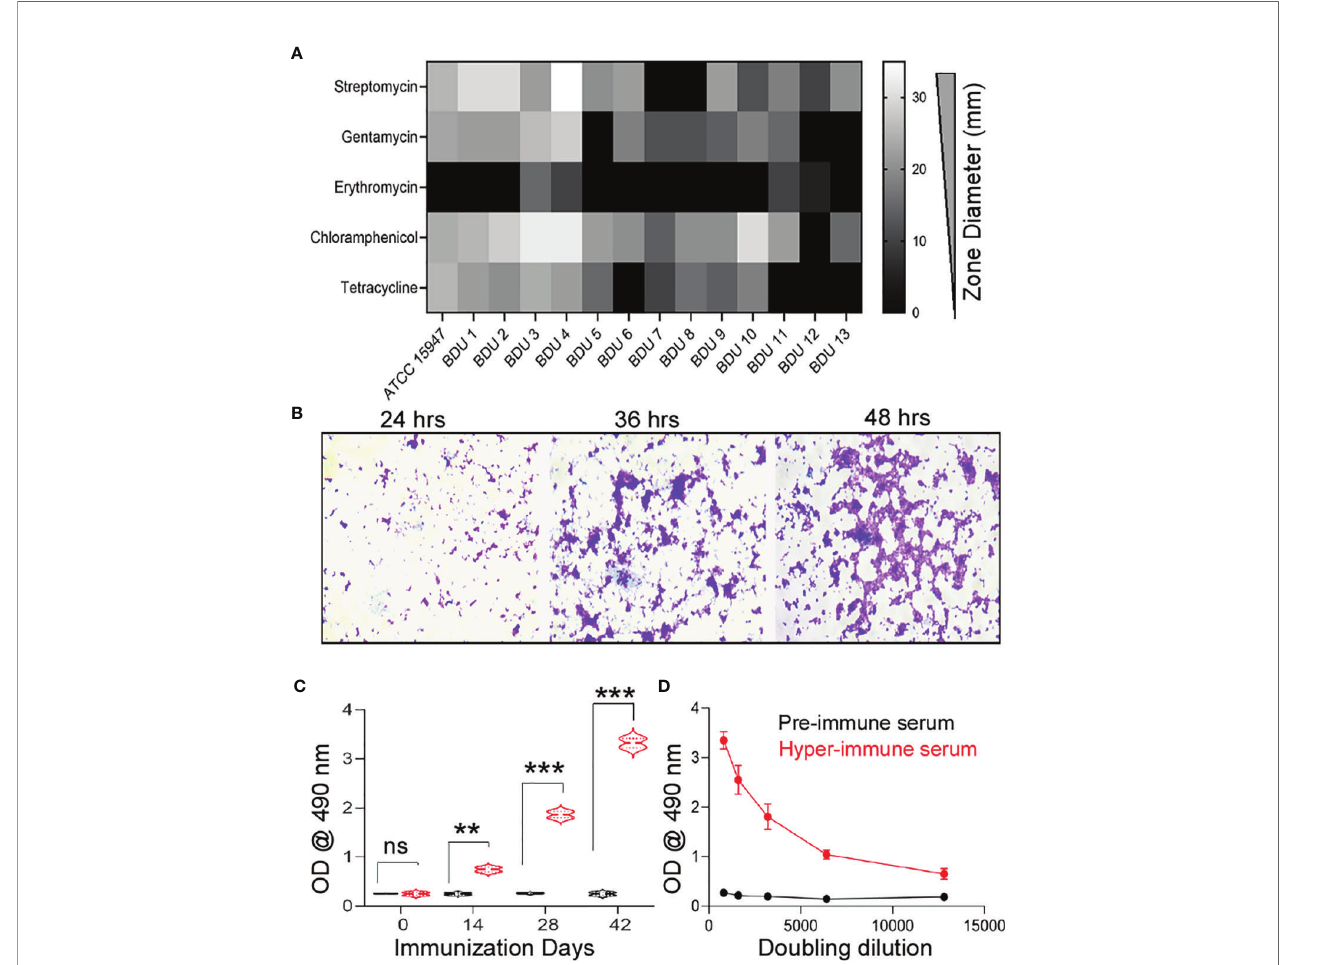
FIGURE 1 | (A) Antimicrobial Resistance of the E. tarda ATCC 15947 and the clinical isolates. x-axis: Antimicrobial zone in millimeter, y-axis: different antimicrobial agents. (B) Bio fi lm forming ability of the strain E. tarda ED-BDU1 at different time intervals (400X). (C) Immune response in rabbits against the live antigen of ED- BDU1 at different days of immunization. X-axis- Immunization days, Y-axis- OD @ 490 nm, ns, no signi fi cance, **P < 0.01, ***P < 0.001. (D) Doubling dilution of the polyclonal rabbit antisera raised against the live antigen of ED-BDU1, X-axis- Doubling dilution of the sera taken after 42 days of immunization, Y-axis- OD @ 490